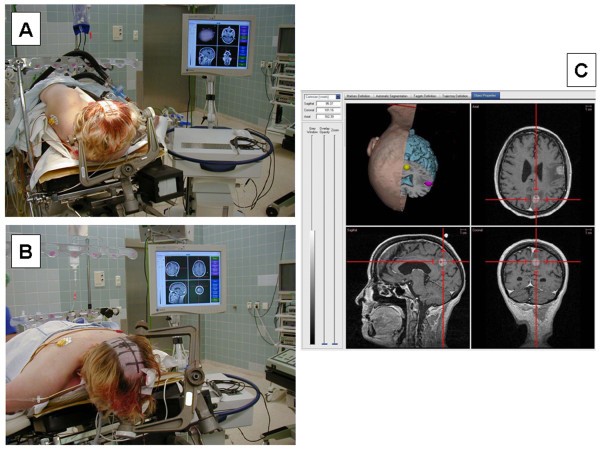
Type B1 fixation of the head. (A) Patient positioned on the right side for resection of a left frontal metastasis. (B) After repositioning in the prone position for resection of a left parieto-occipital metastasis. (C) Screenshot of the navigation system showing the location of the two tumours. 3p = Three point; r.a. = retroauricular.